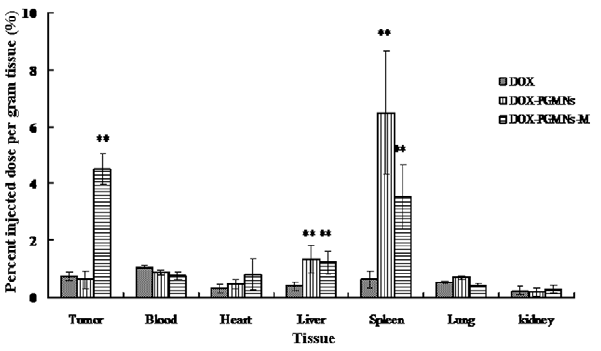
Figure 3. The percent injected dose per gram tissue in tumor, plasma and main organs of H22 tumor–bearing mice that received different treatments. The percent injected dose per gram tissue in the tumors of mice in the DOX-PGMNPs-M group was much higher than that in tumors of mice in the DOX-PGMNPs group or the DOX group. DOX(H22 tumor-bearing mice that treated with doxorubi- cin; DOX-PGMNPs (H22 tumor-bearing mice that treated with DOX- PGMNPs conjugate suspension); DOX-PGMNPs-M (H22 tumor-bearing mice injection DOX-PGMNPs conjugate suspension and subjected to a 0.5 tesla EMF focused onto the tumor for 0.5 hr).* p , 0.05; ** p , 0.01 compared with controls using Student’s unpaired t-test.